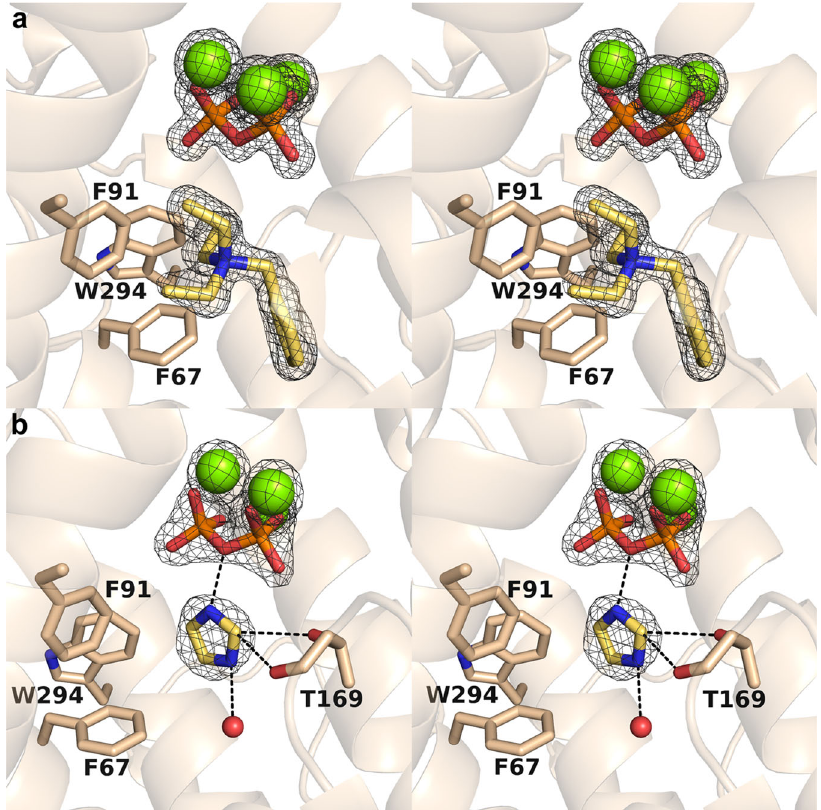
Fig. 5 Binding of ligands in the active site of FgGS. a Stereoview of Polder omit maps of Mg 2 + ions (contoured at 9.0 σ ), PP i (contoured at 16.0 σ ), and BTAC (contoured at 6.5 σ ) in the FgGS – Mg 2 + 3 – PP i – BTAC complex. b Stereoview of Polder omit maps of Mg 2 + ions (contoured at 5.0 σ ), PP i (contoured at 7.0 σ ), and imidazole (contoured at 6.0 σ ) in the FgGS – Mg 2 + 3 – PP i – imidazole complex, with hydrogen bonds indicated by dashed black lines.